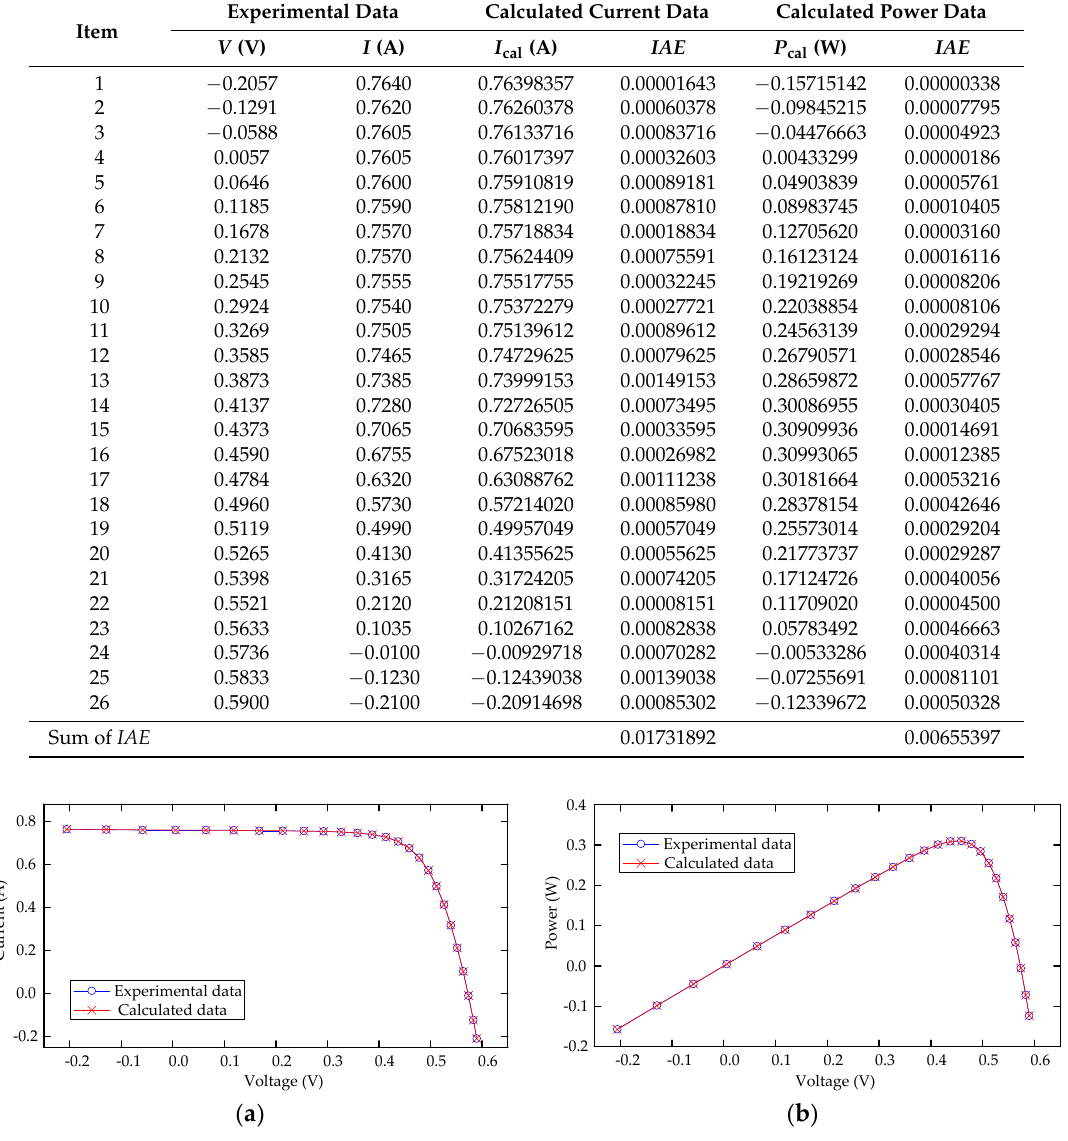
Table 6. The calculated results of the proposed ImCSA for the DDM of RTC France silicon solar cell.